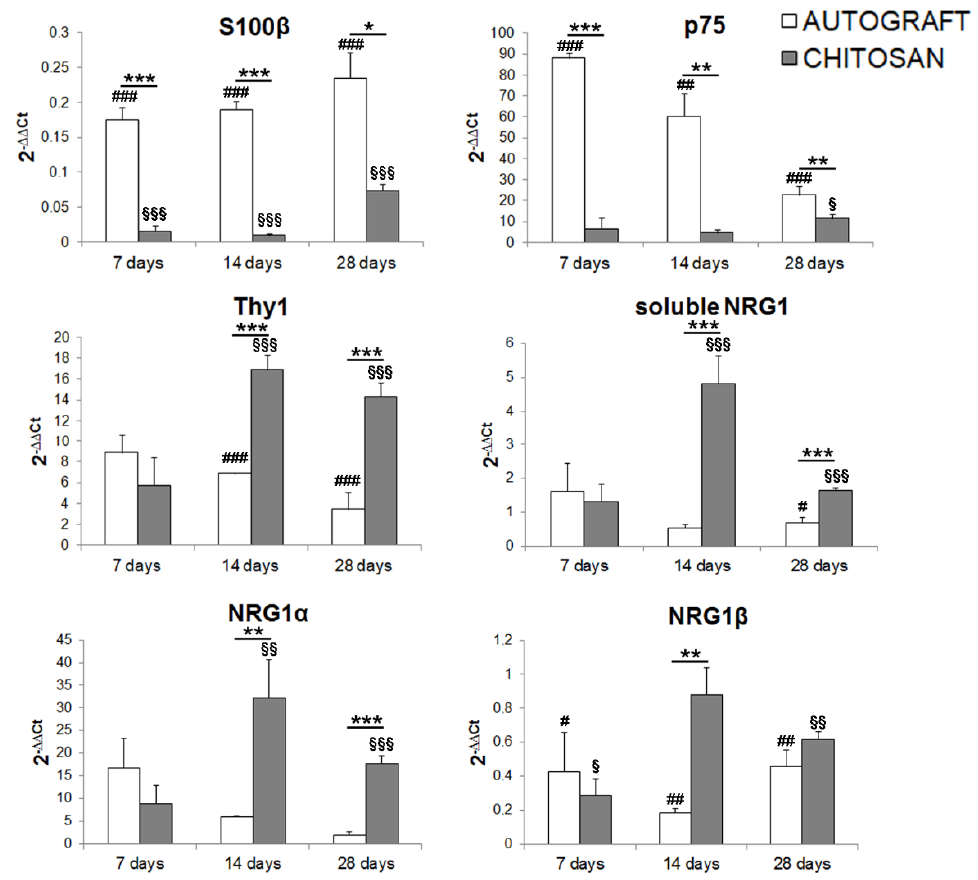
Figure 2. Quantitative expression analysis of Schwann cell and nerve fibroblast markers. Relative quantification (2 − ∆∆ Ct ) of S100 β and p75 (Schwann cell markers), Thy1 (fibroblast marker), soluble NRG1, NRG1 α , and NRG1 β was evaluated by qRT-PCR. The geometric average of the housekeeping genes ANKRD27 and RICTOR was used to normalize data. Values in the graphics are expressed as mean + SEM ( n = 3–4 for each group). ANOVA for repeated measures with Bonferroni’s correction was adopted for statistical analysis; * denotes the significant di ff erences between autograft and chitosan groups at each time point analyzed (* p ≤ 0.05, ** p ≤ 0.01, and *** p ≤ 0.001); # denotes the significant di ff erences between autograft group and uninjured control nerves at each time point analyzed ( # p ≤ 0.05, ## p ≤ 0.01, and ### p ≤ 0.001); § denotes the significant di ff erences between chitosan group and uninjured control nerves at each time point analyzed ( § p ≤ 0.05, §§ p ≤ 0.01, and §§§ p ≤ 0.001). All data are calibrated to uninjured nerves (whose expression, not shown, is = 1).